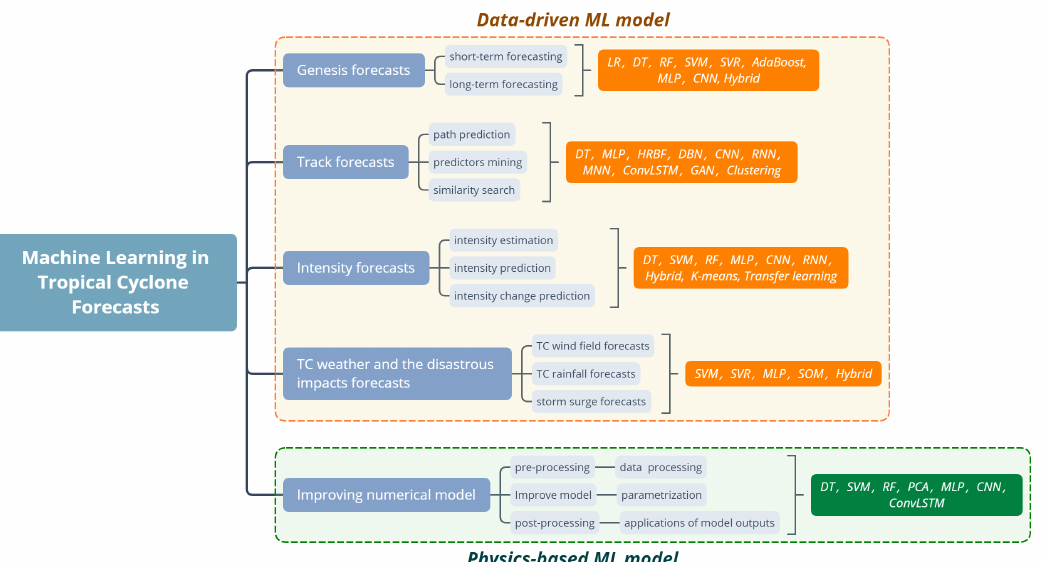
Figure 2. An organization chart of cases involving machine learning in tropical cyclone